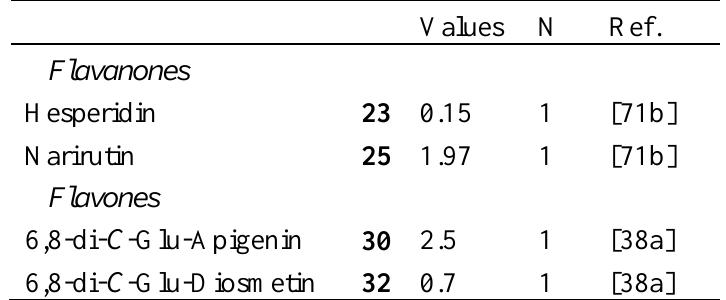
Table 10 . Flavonoid composition of C. deliciosa juice (mg/100 mL).